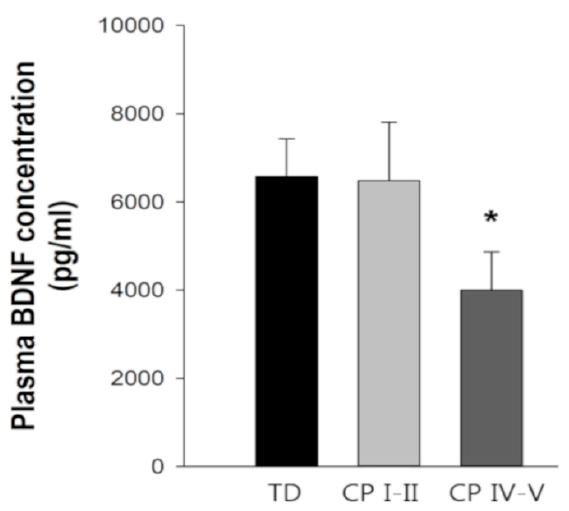
Figure 4. Fasting plasma brain-derived neurotrophic factor (BDNF) concentration in TD children ( n = 15) and children with CP at GMFCS level I–II ( n = 13) and IV–V ( n = 11). Data are means ± SEM. One-way ANOVA with Tukey post-hoc test was performed. * p < 0.05 compared to TD.